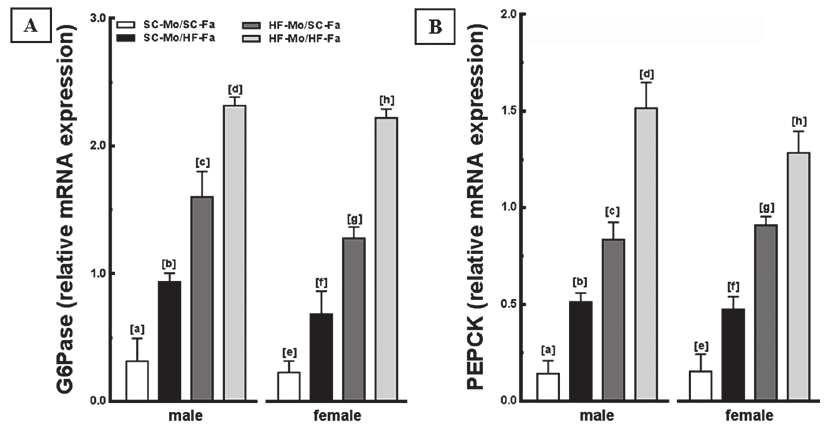
Fig 6. Molecular analyses in the offspring liver (panel 2). (A) G6Pase and (B) PEPCK mRNA levels of the male and female offspring at 12-weeks old. Endogenous control beta-actin was used to normalize the expression of the selected genes. Data are expressed as the mean and SD (n = 5 mice per group, one-way ANOVA and the posthoc test of Holm – Sidak). Same letters represent equal groups with no statistical difference while different letters represent different groups from each other, with statistical difference ( P < 0.05), * different from the corresponding counterpart ( P < 0.05). Abbreviations: